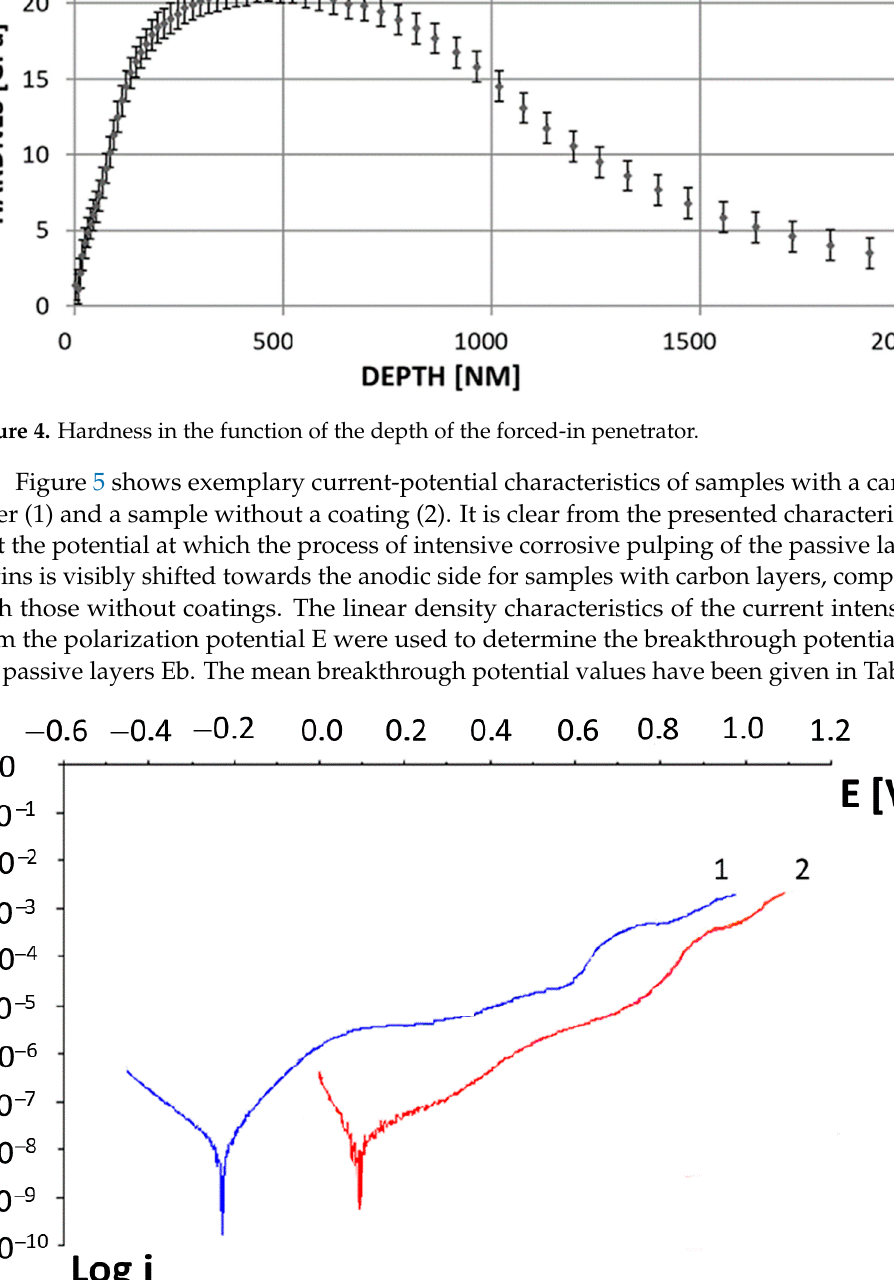
Figure 3. Raman spectra of examined samples.